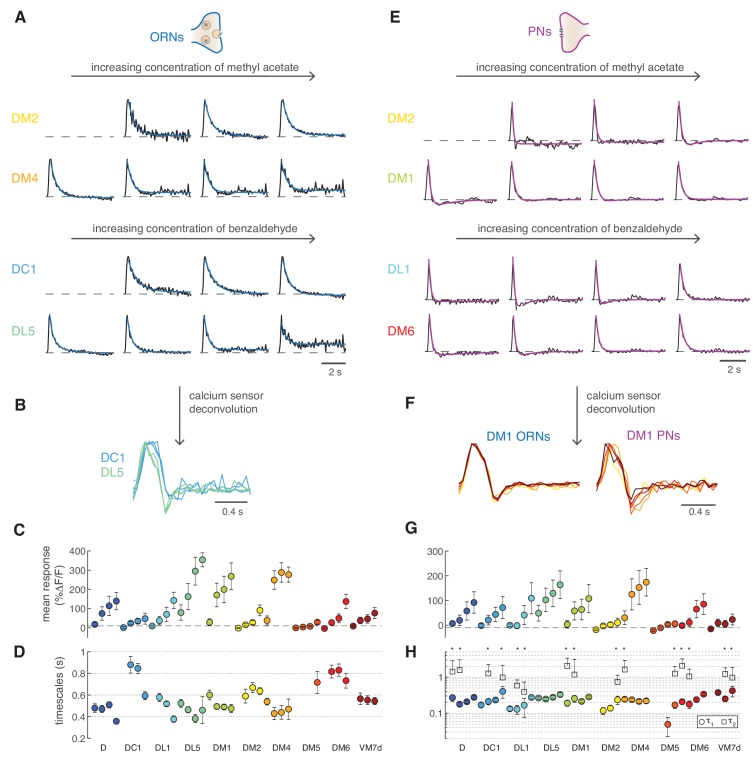
Calcium dynamics in ORNs and PNs.(A) Linear filters (black) and corresponding exponential fit (cyan) for ORNs in four glomeruli at four concentrations of the stimulus. Two odors were used (methyl acetate and benzaldehyde) that capture the response of two non-overlapping sets of glomeruli. Responses below 10% ΔF/F were removed from further analysis because of an insufficient signal-to-noise ratio (n = 4–11). (B) Example of the linear filters obtained after deconvolution of the calcium sensor, color indicates glomerulus identity and different curves correspond to different stimulus intensities. (C) Mean responses to the fluctuating stimulus averaged over time for 10 glomeruli (color coded) at four stimulus intensities (same color). Error bars indicate standard deviations. Dashed lines indicate a threshold of 10% ΔF/F. (D) Timescale τ1 of the linear filter resulting from the exponential fit. Error bars indicate 95% confidence intervals. Timescale of the linear filters is significantly anticorrelated to mean response (R = −0.6; p<0.0004), glomerulus dependent (p<10−6) and slightly dependent on stimulus intensity (p<0.02; two-way analysis of variance). Sample size per glomerulus was: nD = 6, nDC1 = 7–8, nDL1 = 7–8, nDL5 = 7–8, nDM1 = 9–11, nDM2 = 9–11, nDM4 = 9–11, nDM5 = 7–8, nDM6 = 7–8, and nVM7d=4–6. (E) Linear filters (black) and corresponding exponential fit (purple) for PNs in four glomeruli at four concentrations of the stimulus. For each glomerulus, three models were fitted (single exponential, single exponential plus a constant, and double exponential, see Materials and methods). The model with the lowest BIC was selected. The shape of the linear filter in PNs depends on stimulus intensity. (F) Linear filter obtained from calcium responses after deconvolution of the sensor kinetics, showing that PNs filters are concentration dependent. Color indicates concentration as in Figure 2D. (G) Same as in C for PNs. (H) Timescales of the linear filter resulting from the exponential fit. Stars (*) indicate data sets that were fitted by a double exponential (model 3): in this case, a second timescales τ2 is shown, which is associated to the negative lobe pf the double exponential. τ1 is slightly correlated with the mean response (R = 0.4, p<0.02), whereas τ2 is independent from it (p>0.05). Differences between glomeruli are not significant (Kruskal-Wallis test, p>0.05). The sample size per glomerulus was as follows: nD = 7, nDC1 = 3–4, nDL1 = 6–7, nDL5 = 7–8, nDM1 = 6–7, nDM2 = 6–7, nDM4 = 6–7, nDM5 = 5–7, nDM6 = 7–8, and nVM7d = 6–7.